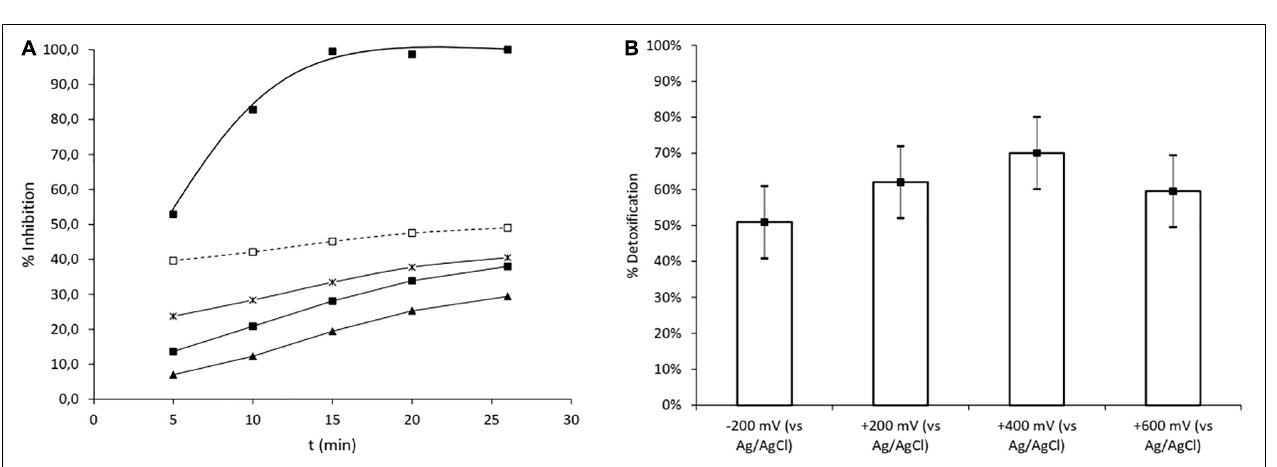
FIGURE 5 | Comparison of the micropollutant and TOC removal of the ME-FBR and the UASB reactor. Symbols: (cid:4) % TOC removal, (cid:3) average current density (A m − 3 ME-FBR).